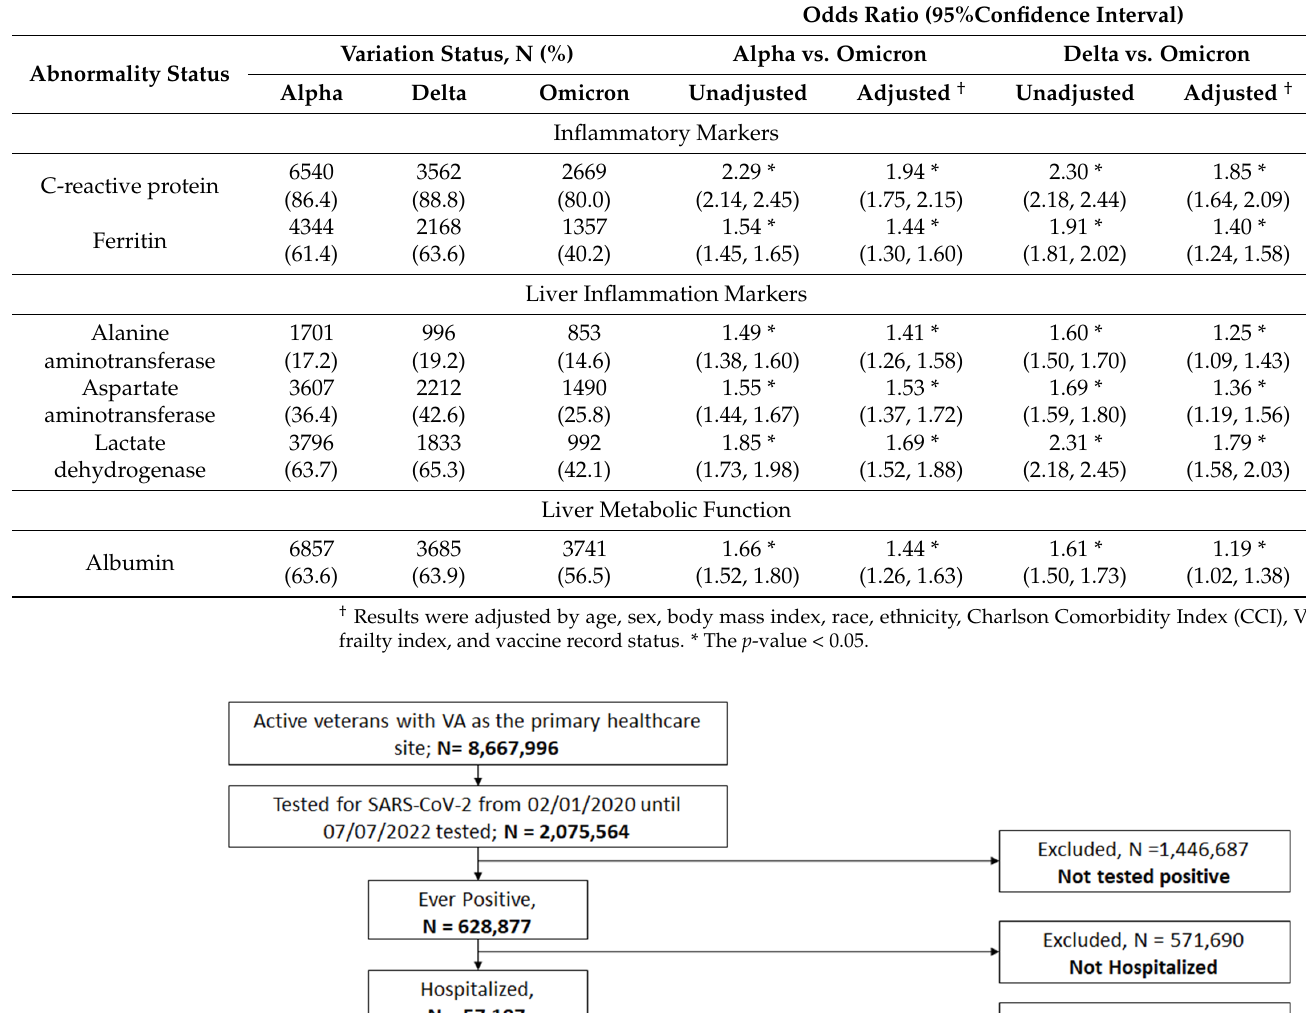
Table 2. Comparing the abnormality after testing positive for COVID-19 among 3 variants groups: Alpha, Delta, and Omicron.